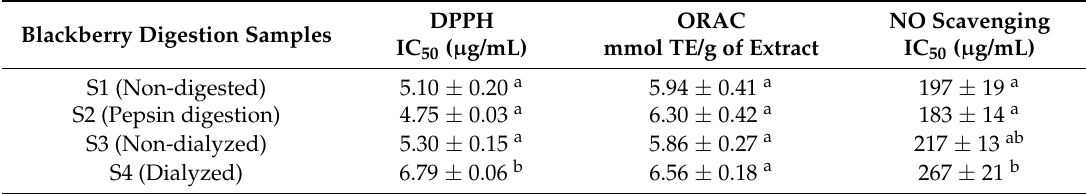
Table 2. Free radical-scavenging of the digested blackberry juice polyphenols.